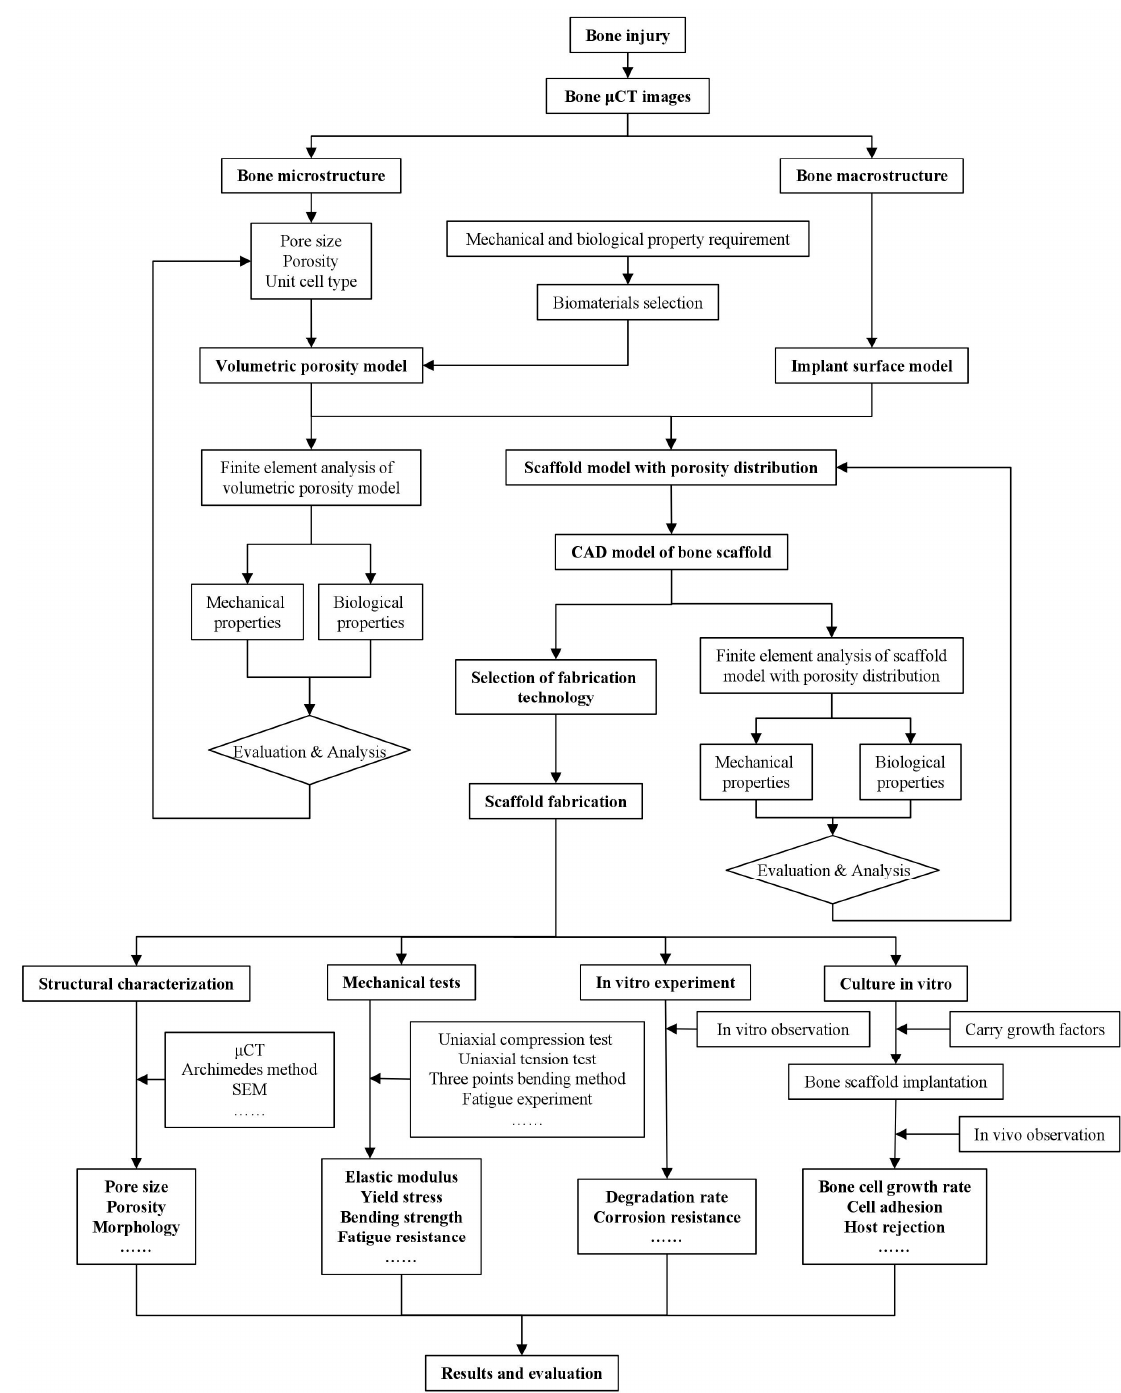
Figure 1. Procedure of design, fabrication and evaluation of BTE scaffolds. µ CT, micro-computed tomography.